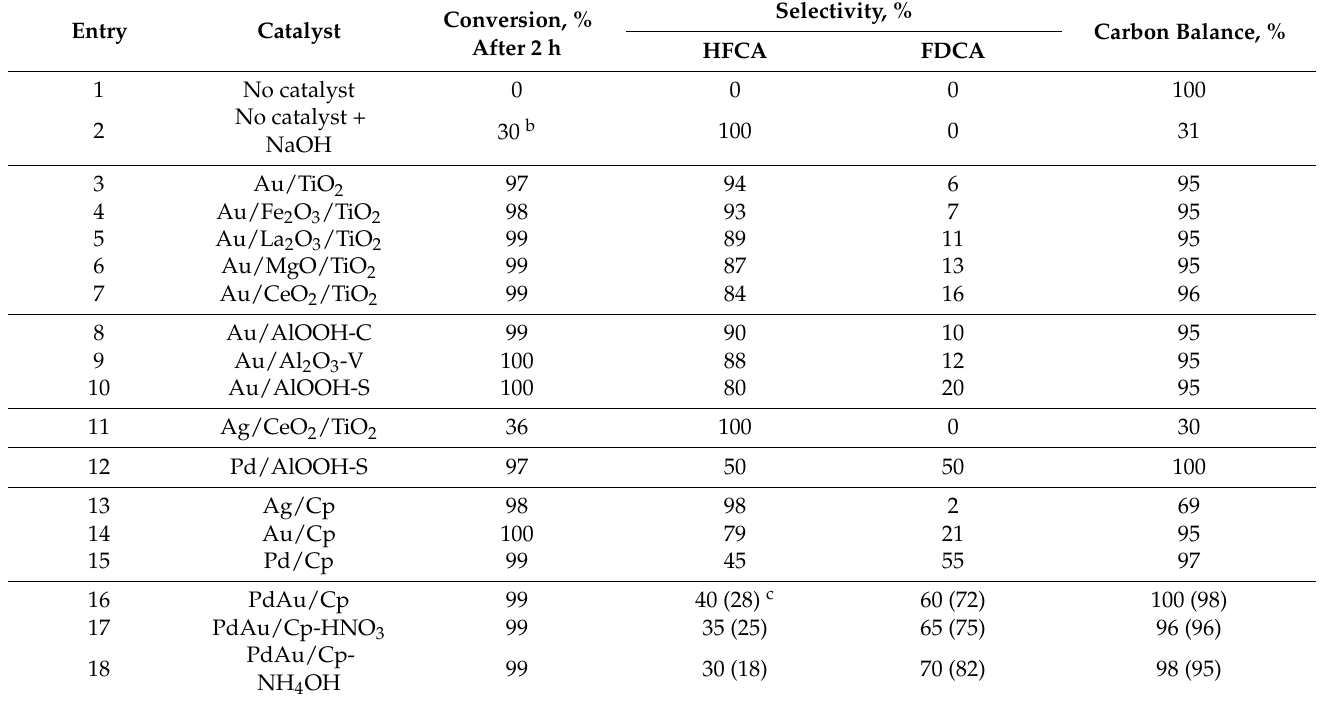
Table 1. Catalytic behavior of supported Ag, Au, Pd and PdAu NPs on different materials for HMF oxidation under basic conditions a .